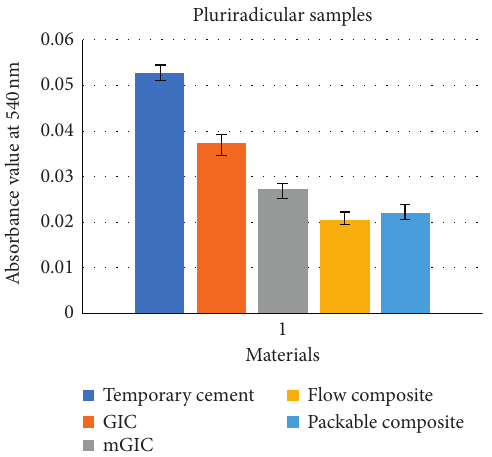
Figure 6: Mean value for all materials for pluriradicular